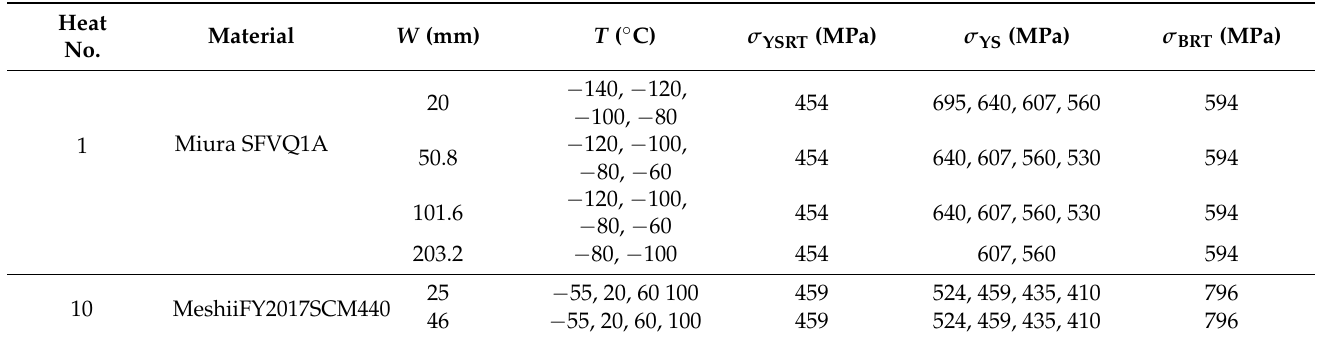
Table 6. Explanatory variables for case studies applied to the developed